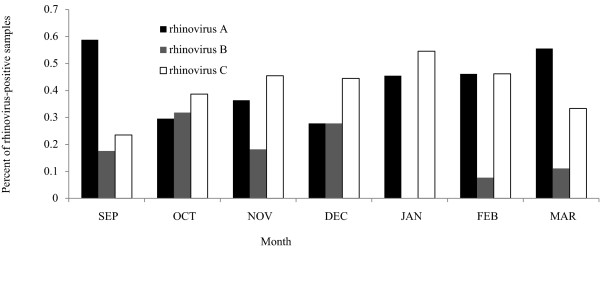
Distribution of human rhinovirus A, B, and C detected in samples from September 2009 to March 2010. Data from May-Aug 2009 and Apr-May 2010 is not shown due to low number of rhinovirus-positive samples. Each bar represents the percentage of all sequenced rhinoviruses detected in that month.